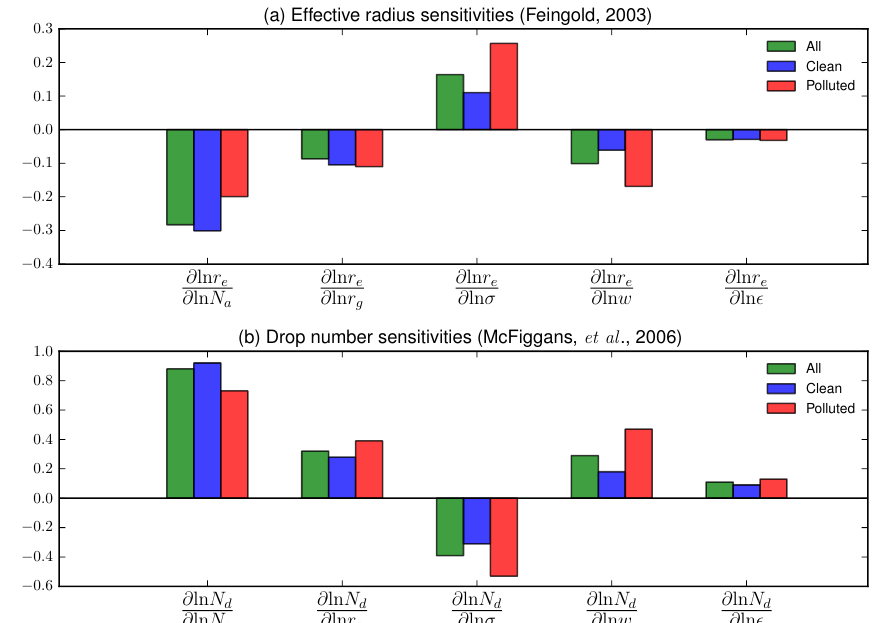
Figure 1. Sensitivities of (a) drop effective radius ( r e ) (Feingold, 2003) and (b) drop number concentration ( N d ) (McFiggans et al., 2006) to aerosol number concentration ( N a ), aerosol median size ( r g ), breadth parameter ( σ ) for the uni-modal log-normal distribution assumed for aerosol sizes, vertical velocity ( w ), and aerosol mass fraction ( (cid:15) ) of ammonium sulfate. The drop effective radius r e is the ratio of the number-weighted radius cubed to the number-weighted radius